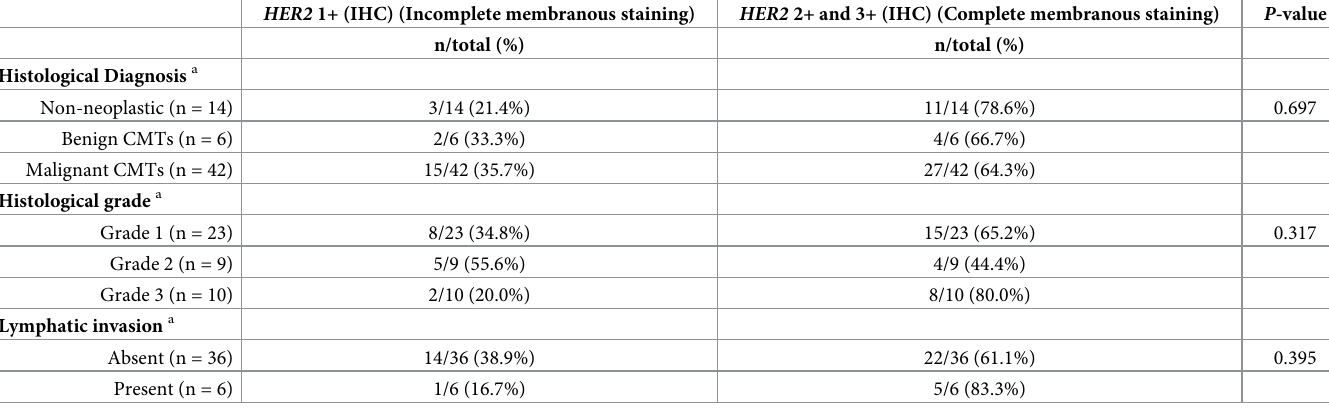
Table 3. Association between HER2 IHC score and parameter including histological diagnosis, histological grade, presence of lymphatic invasion. HER2 1+ (IHC) (Incomplete membranous